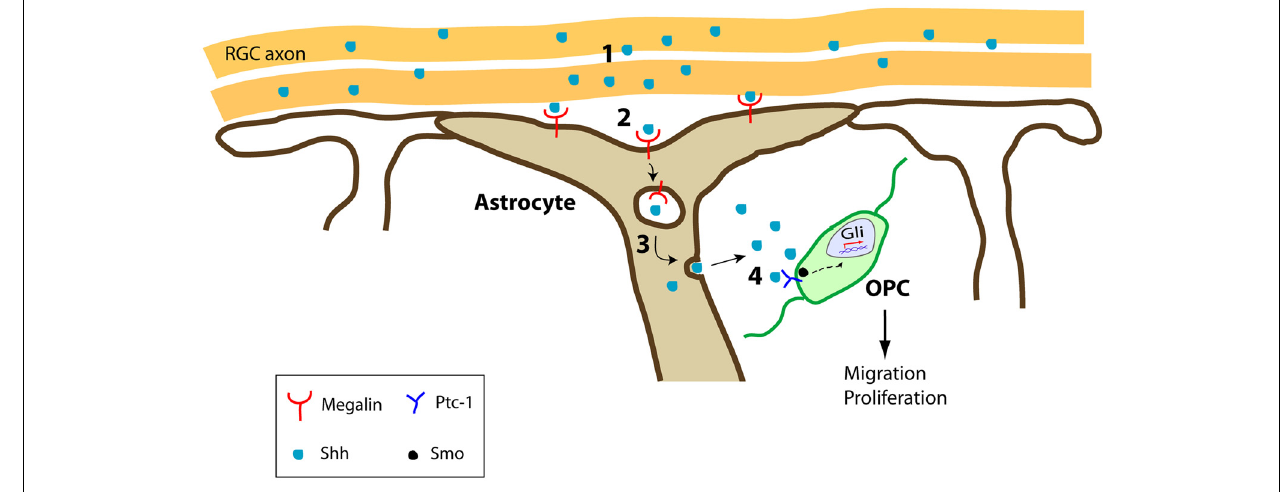
FIGURE 1 | Schematic representation of the optic nerve trafficking of Shh by megalin + -astrocytes. (1) RGC axons secrete Shh during optic nerve development. (2) Shh is internalized by megalin + -astrocytes. (3) Shh is